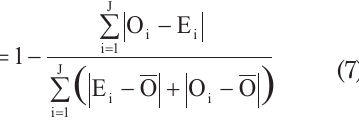
observado experimentalmente; Ei, o valor estimado pelo modelo; e O , a média dos valores observados experimentalmente. No quadro 4 são apresentados os critérios de avaliação do desempenho de modelos quanto ao seu índice de confiança.